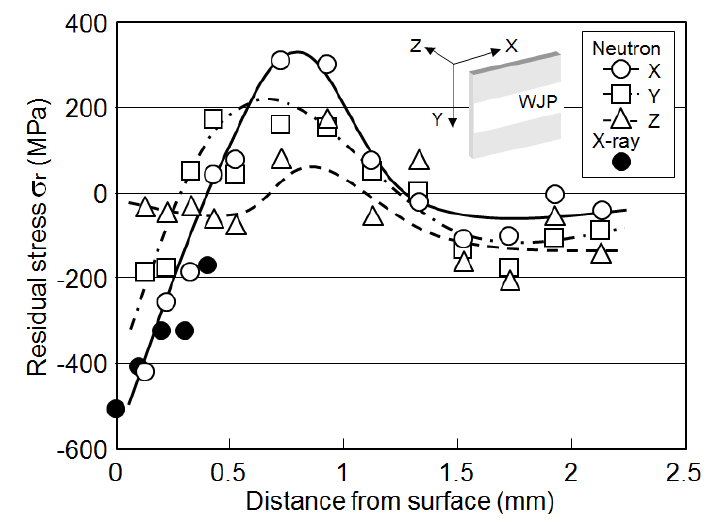
Figure 12. Residual stress distributions in near-surface of water jet peened type 304 stainless steel plate considering the pseud peak shift.